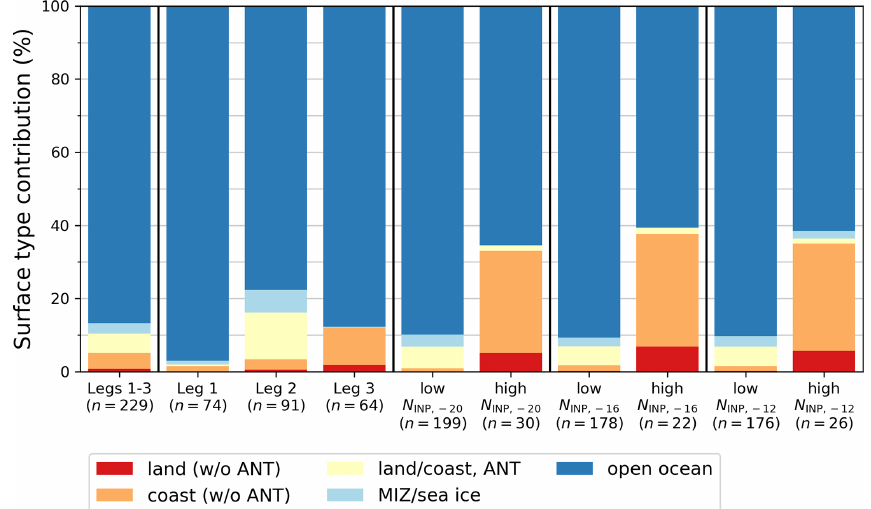
Figure 7. Percents of surface type over-passed by 10d backward trajectories (see Sect. 2.4 and Text S1 in the Supplement for details). Colour codes for surface types are non-Antarctic land masses (red), non-Antarctic coastal regions or islands (orange), Antarctic continent or coastal regions (ANT; yellow), ice-covered regions (light blue), and open ocean (dark blue). From left to right, the different surface contributions to the air masses are shown for the entire circumnavigation (Legs 1–3), separated by leg (see Fig. 1), and cases of N INP , − 20 below (“low”) or above 40m − 3 (“high”), N INP , − 16 below/above 10m − 3 , and N INP , − 12 below/above 4m − 3 are analogous to ranges indicated in the respective PDF (see Fig. 8b–d). The number of trajectory clusters ( n ) are indicated in the figure. Trajectory maps for ACE are available at an hourly resolution from Thurnherr et al.